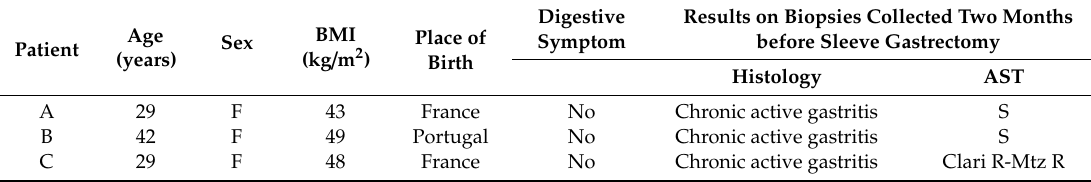
Table 1. Patient characteristics before sleeve gastrectomy.